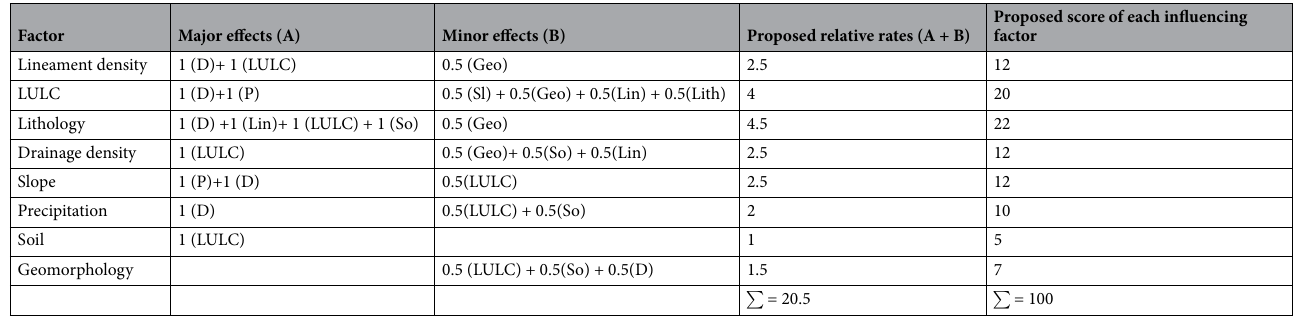
Table 3. Ranking of influencing